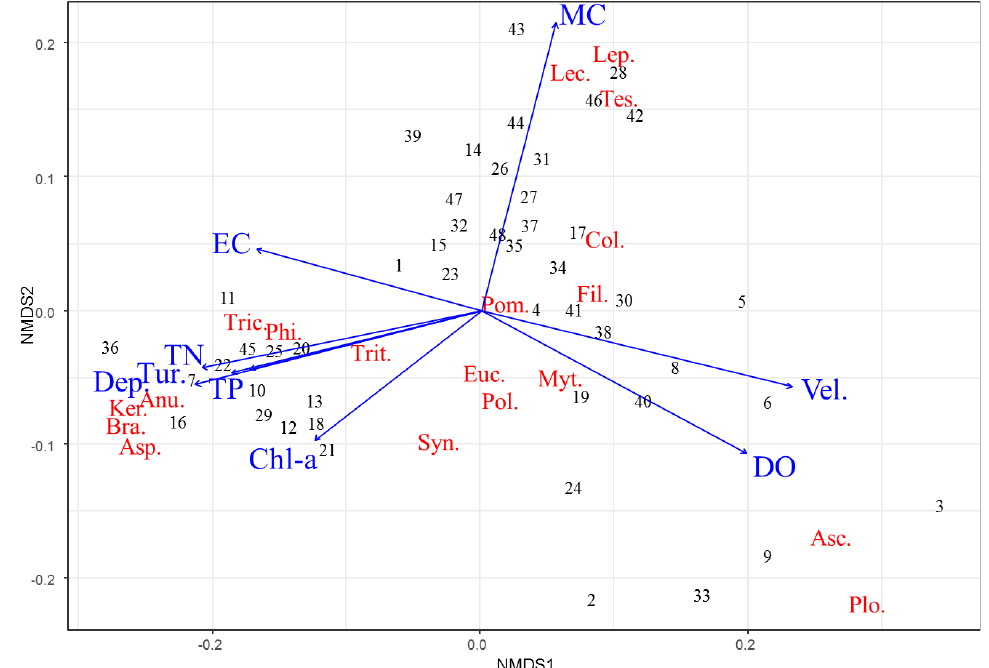
Figure 3. Nonmetric multidimensional scaling (NMDS) of 20 rotifer genera (red text) and 48 artificially created riverine wetlands (numbers). The blue arrows represent the associations with environmental variables: DO, dissolved oxygen; EC, conductivity; Tur., turbidity; TN, total nitrogen; TP, total phosphorus; Chl- a , chlorophyll a ; Dep., depth; Vel., velocity; MC, macrophyte coverage; Anu., Anuraeopsis ; Asc., Ascomorpha ; Asp., Asplanchna ; Bra., Brachionus ; Col., Colurella ; Euc., Euchlanis ; Fil., Filinia ; Ker., Keratella ; Lec., Lecane ; Lep., Lepadella ; Mit., Mytilina ; Phi., Philodina ; Plo., Ploesoma ; Pol., Polyarthra ; Pom., Pomplholyx ; Syn., Synchaeta ; Tes., Testudinella ; Tric., Trichocerca ; Trit., Trichotria .